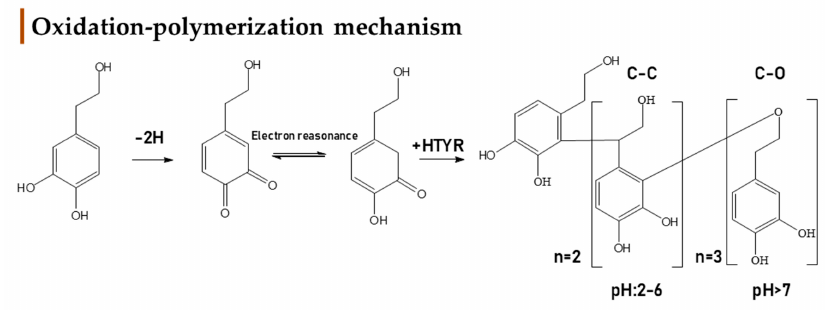
Figure 11. Mechanistic approach of HTyr’s oxidation and dimerization under conditions described in bibliography